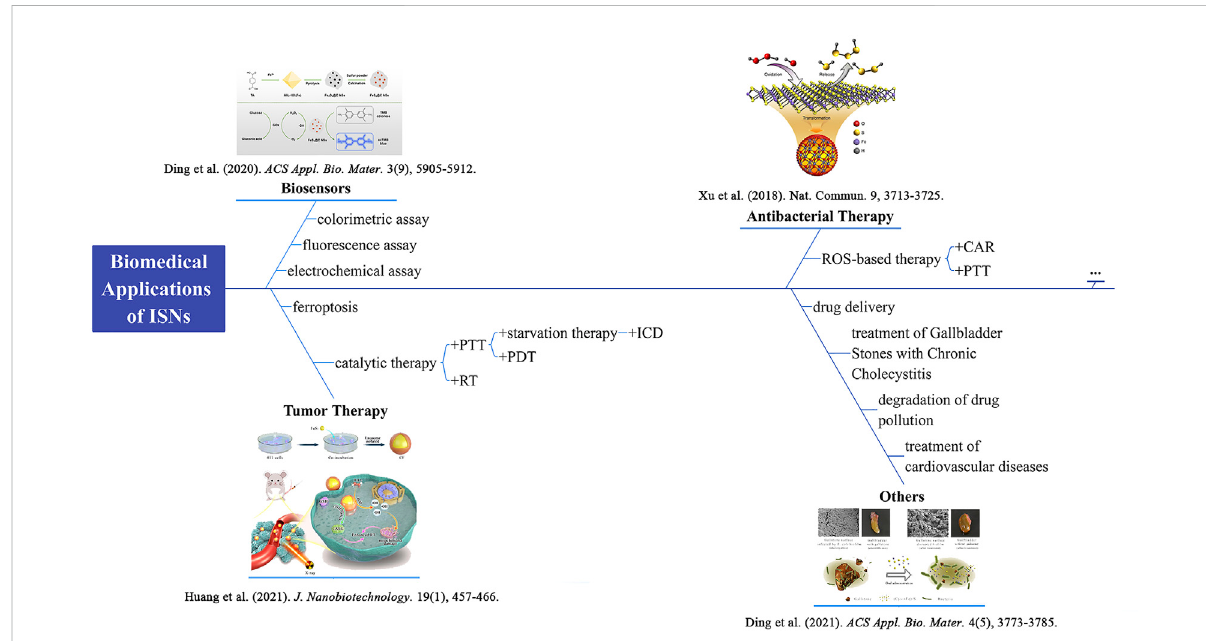
SCHEME 1 Schematic diagram of biomedical applications of ISNs. Schematics for FeS 2 @C NSs. Reproduced with permission from Ref. (Ding et al., 2020). Copyright © 2020 American Chemical Society. Schematics for a biomimetic nanozyme system (CF) by coating FeS 2 into tumor-derived exosomes. Reproduced with permission from Ref. (Huang et al., 2021). Copyright © 2021 The Author(s). Scheme of polysulfane release from nFeS. Reproduced with permission from Ref. (Xu et al., 2018). Copyright © 2018 The Author(s). Comparison of cholelithiasis and cholecystitis before and after